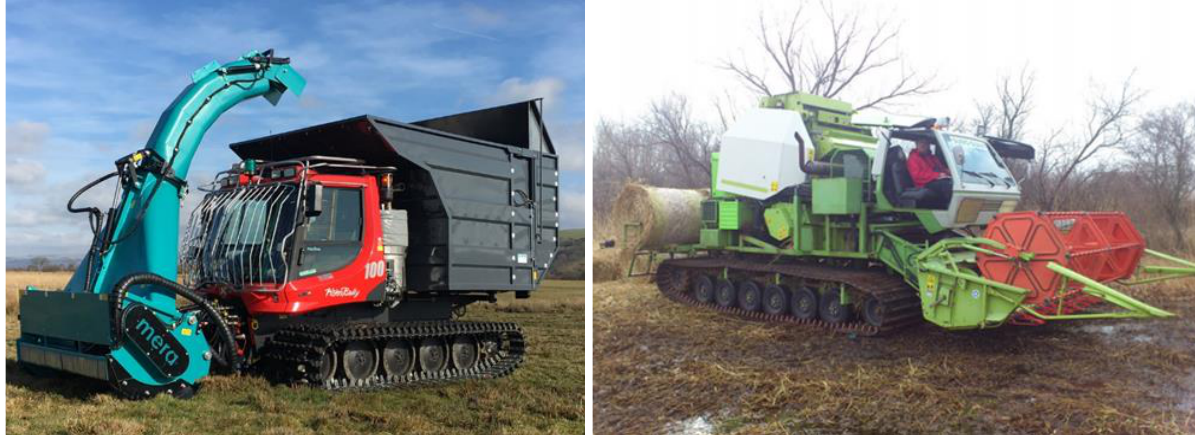
Figure 4. Examples of specialised wetland harvesters from Europe. Left: the tracked wetland harvester Pisten Bully GreenTech 100 (left) manufactured by Kässbohrer (source: http://www.offpisteagri.co.uk/ pictures-worth-seeing.html). Right: the Sumo -Quaxi Machine from Austria that cuts and bales (source: http://duene-greifswald.de/doc/rrr2013/talks/Harvesting%20Techniques%202_Beckmann%202013%20-